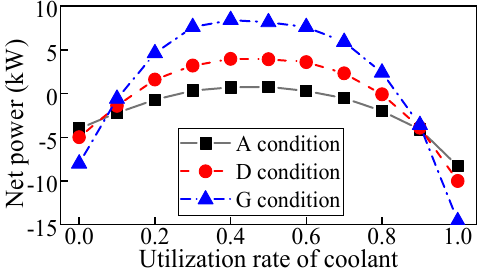
Figure 6. Changes of system net power with coolant utilization rate under conditions A, D, G.